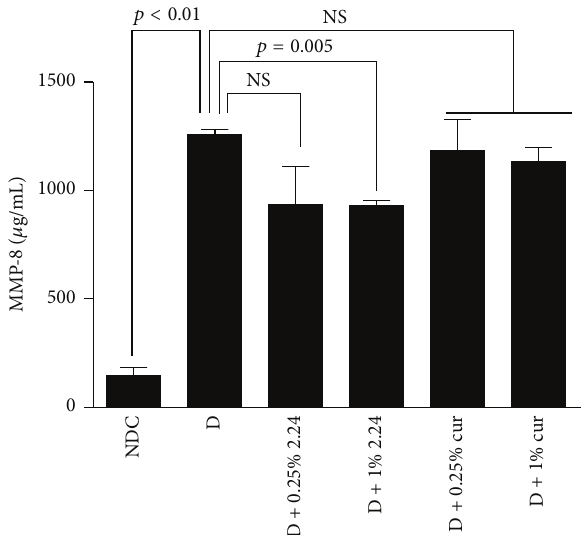
Figure 4: The concentration of MMP-8 (collagenase-2) in the wound extracts from the nondiabetic control (NDC) and diabetic (D) rats treated with vehicle alone or with 0.25% or 1% concentra- tions of CMC2.24 or curcumin. Each value represents the mean of 3 measurements per experimental group ±